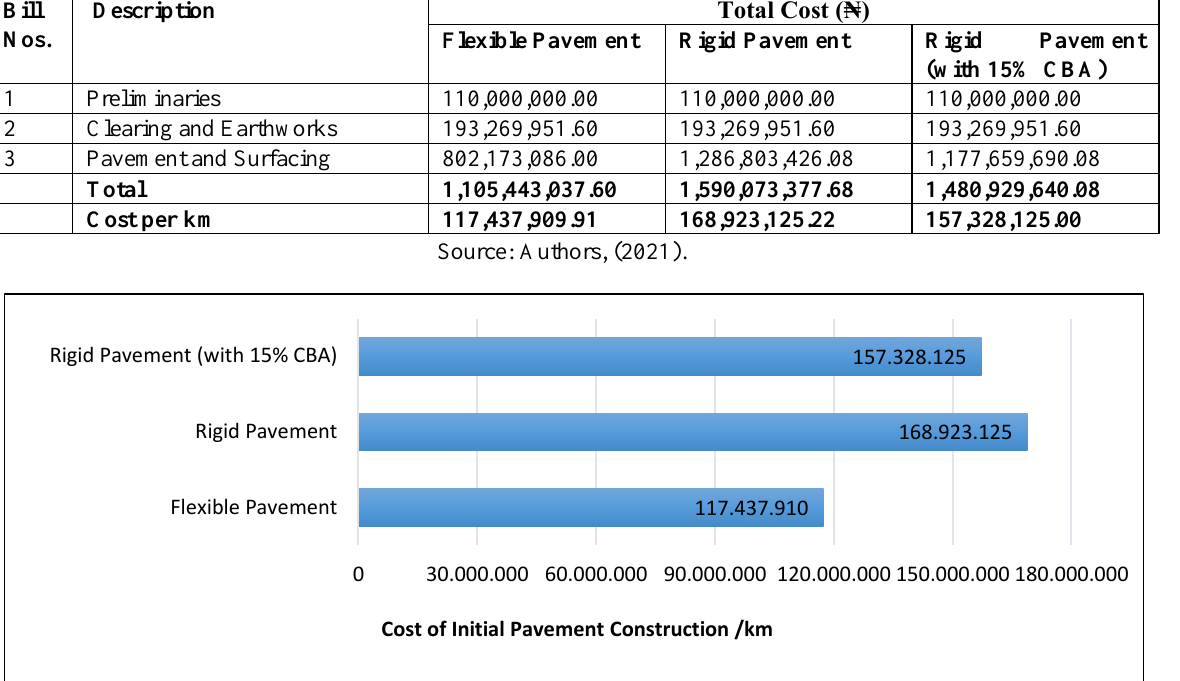
Figure 1: Initial cost comparison between Flexible and Rigid Pavement for a 1KM road